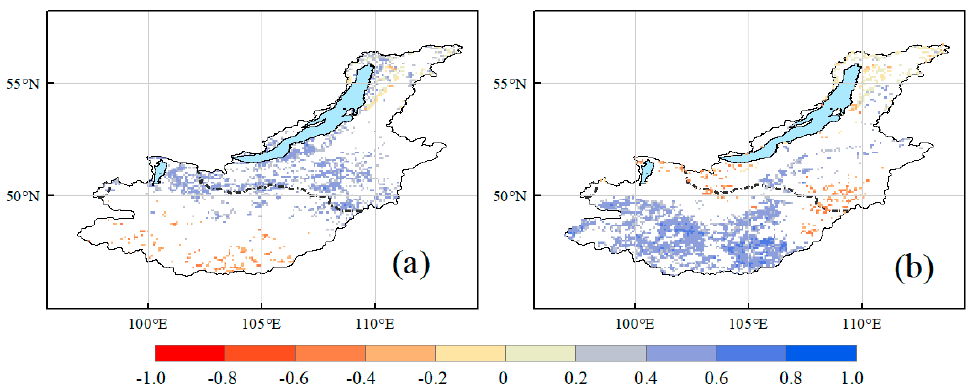
Figure 8. Spatial distribution of the partial correlation coefficients ( p < 0.05) ( a ) between the NDVI and temperature and ( b ) between the NDVI and precipitation.